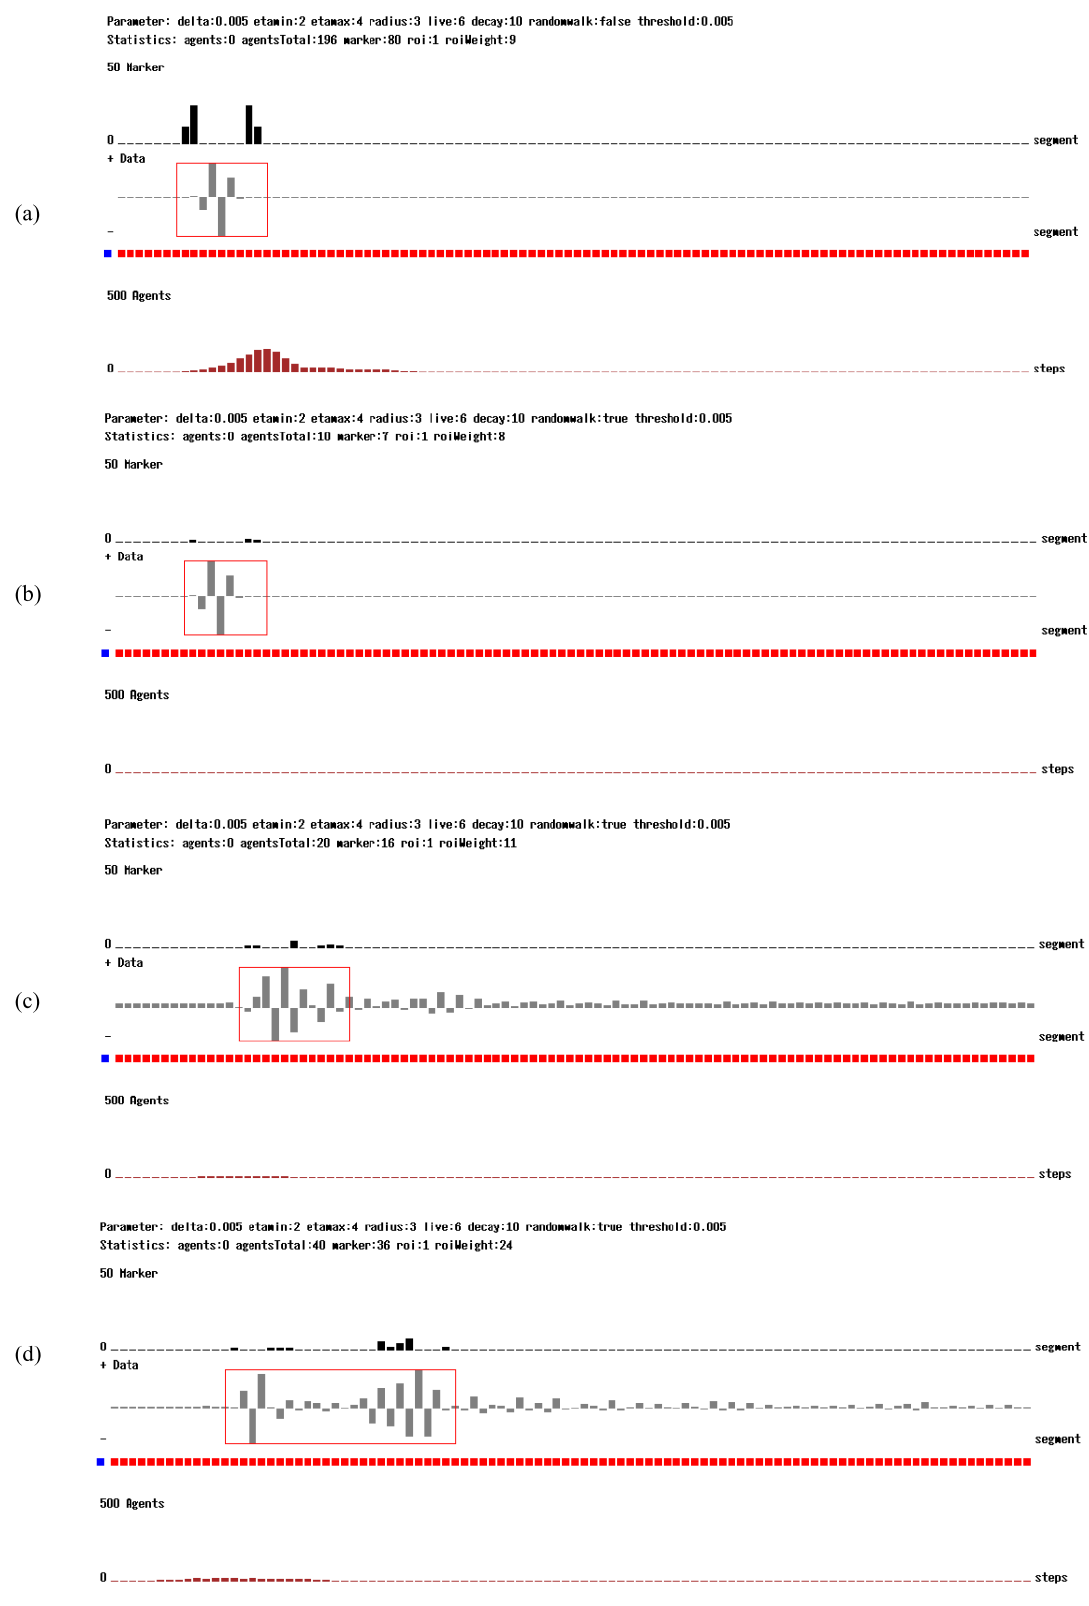
Figure 4. Some selected results of ROI marking using the Self ‐ organizing MAS: ( a , b ) Actor signal ( c , d ) Sensor signal; ( a ) Without random walk ( b – d ) With random walk behaviour ( a , b ) Experiment 105; ( c ) 110 ( d ) 108; all f sample = 150